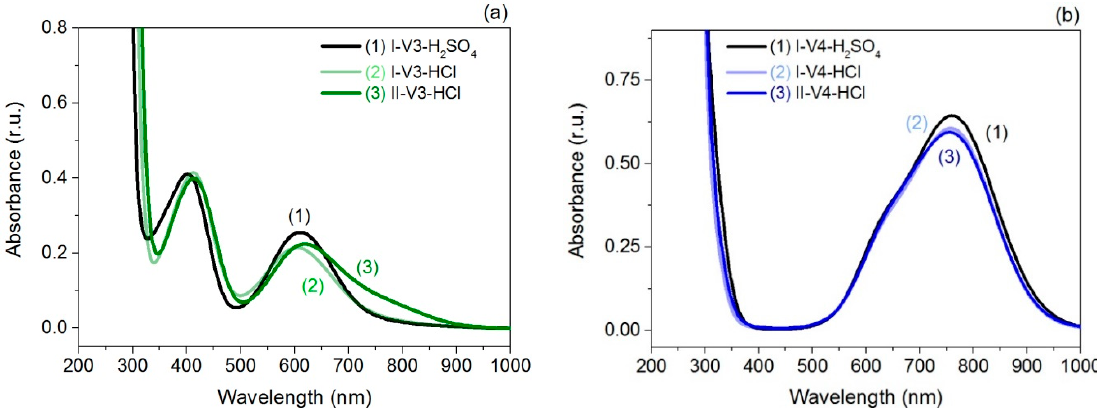
Figure 1. Electronic absorption spectra for ( a ) anolyte and ( b ) catholyte samples.